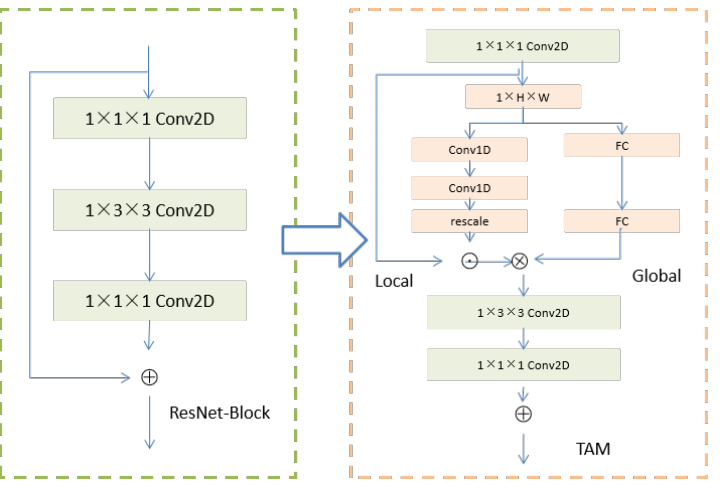
Figure 3. The concrete structure of the TAM module. On the left is an ordinary ResNet block and on the right is the TAM block with local and global feature